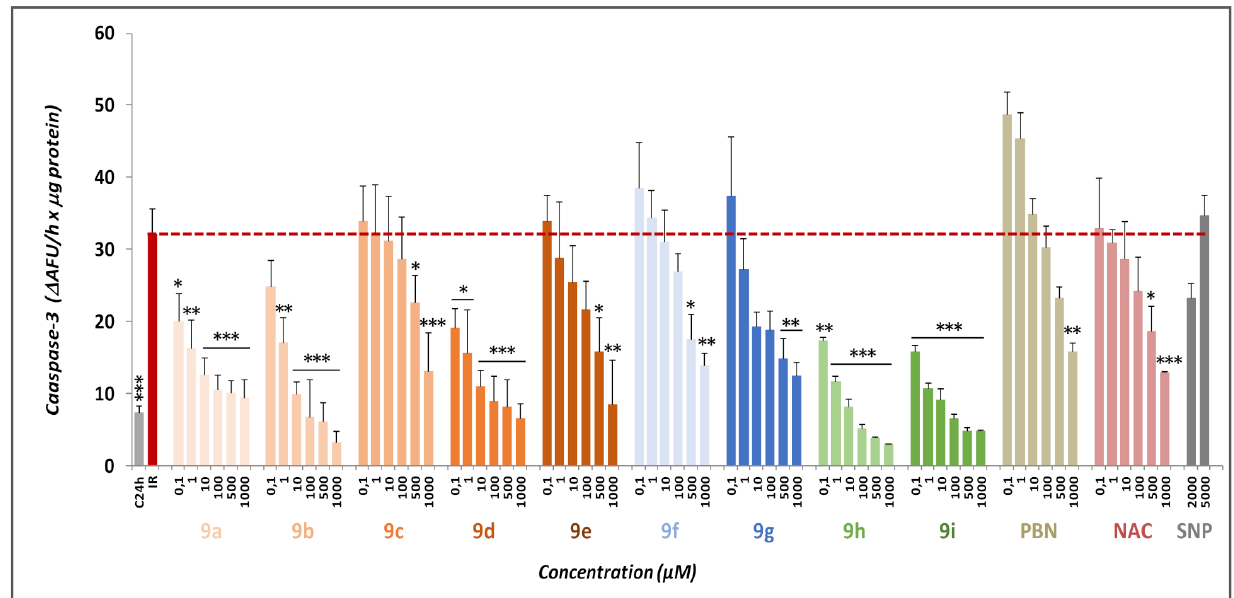
Figure 7. Anti-apoptotic effects of nitrones 9a – 9i , PBN , and NAC against IR treatment in SHSY5Y cells. Bars show caspase 3 activity ( ∆ AFU/min/ µ g protein) after OGDR (IR) treatment, in the absence or presence of 9a – i , PBN , and NAC, at the specified concentrations. Data presentation, curve fitting, and statistical analysis of the data was performed as indicated in Figure 5. UAF = arbitrary fluorescent units. * p < 0.05, ** p < 0.01, and *** p <